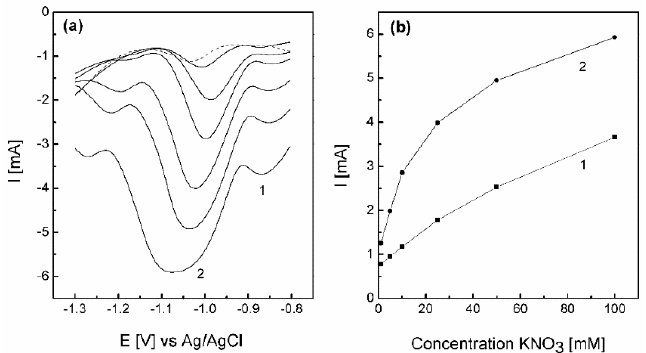
Figure 7. ( a ) Differential pulse voltammetry recorded for restructured Cu galvanically replaced by Au for 5 min in 1 M NaOH containing 0 (dashed line), 1, 5, 10, 25, 50 and 100 mM KNO 3 , and ( b ) a plot of peak height versus concentration for peak 1 and peak 2 identified in ( a ).